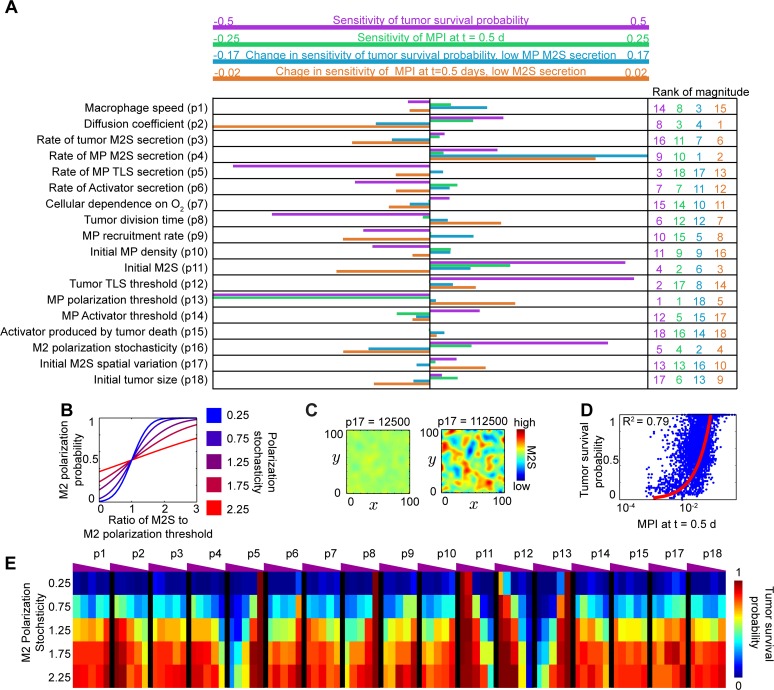
Systematic evaluation of parameter contributions to model behaviors.(A) Using the data from Fig. 4, sensitivities of four different metrics of model behavior were calculated over changes in each of the 18 model parameters. The range of each metric was different (indicated in key at top of panel). For each metric, normalized sensitivities were ranked by parameter (right column). (B) Illustration of M2 polarization probability “dose-response” curves (normalized) for different values of polarization stochasticity. (C) Illustrative spatial distributions of M2S for low and high values of the M2S heterogeneity parameter, p17, depicted at 0.1 d after tumor initiation, after which point initial diffusion had occurred but cellular contributions to the distribution were negligible. (D) Global correlation of tumor survival probability with MPI at t = 0.5 d across all parameter combinations evaluated in Fig. 4. Red lines depict linear regressions, with coefficients shown. (E) Pairwise contributions of polarization stochasticity and all other parameter values to tumor survival probability.